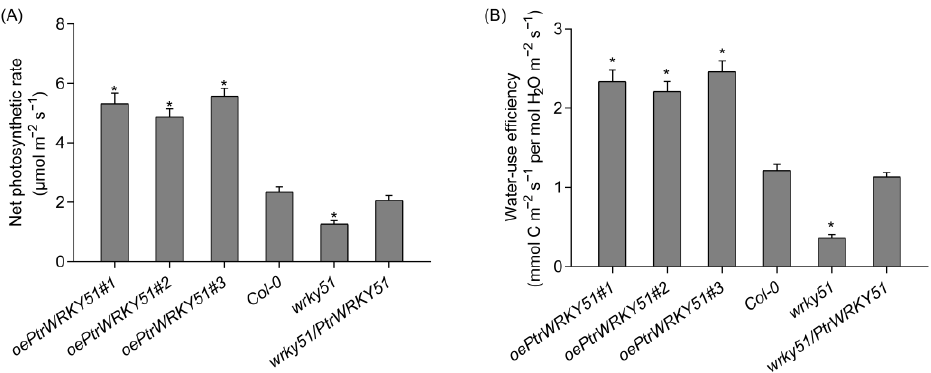
Figure 6. Physiological analysis of over-expressing PtWRKY51 lines under salt stress conditions. Difference in net photosynthetic rate ( A ) and instantaneous leaf WUE ( B ) among oe PtWRKY51 , Col-0, wrky51 , and wrky51 / PtWRKY51 plants under salt stress conditions. The data are represented as means ± SE ( n = 12). The asterisks (*) represent significant differences (* p < 0.05) compared to the control.